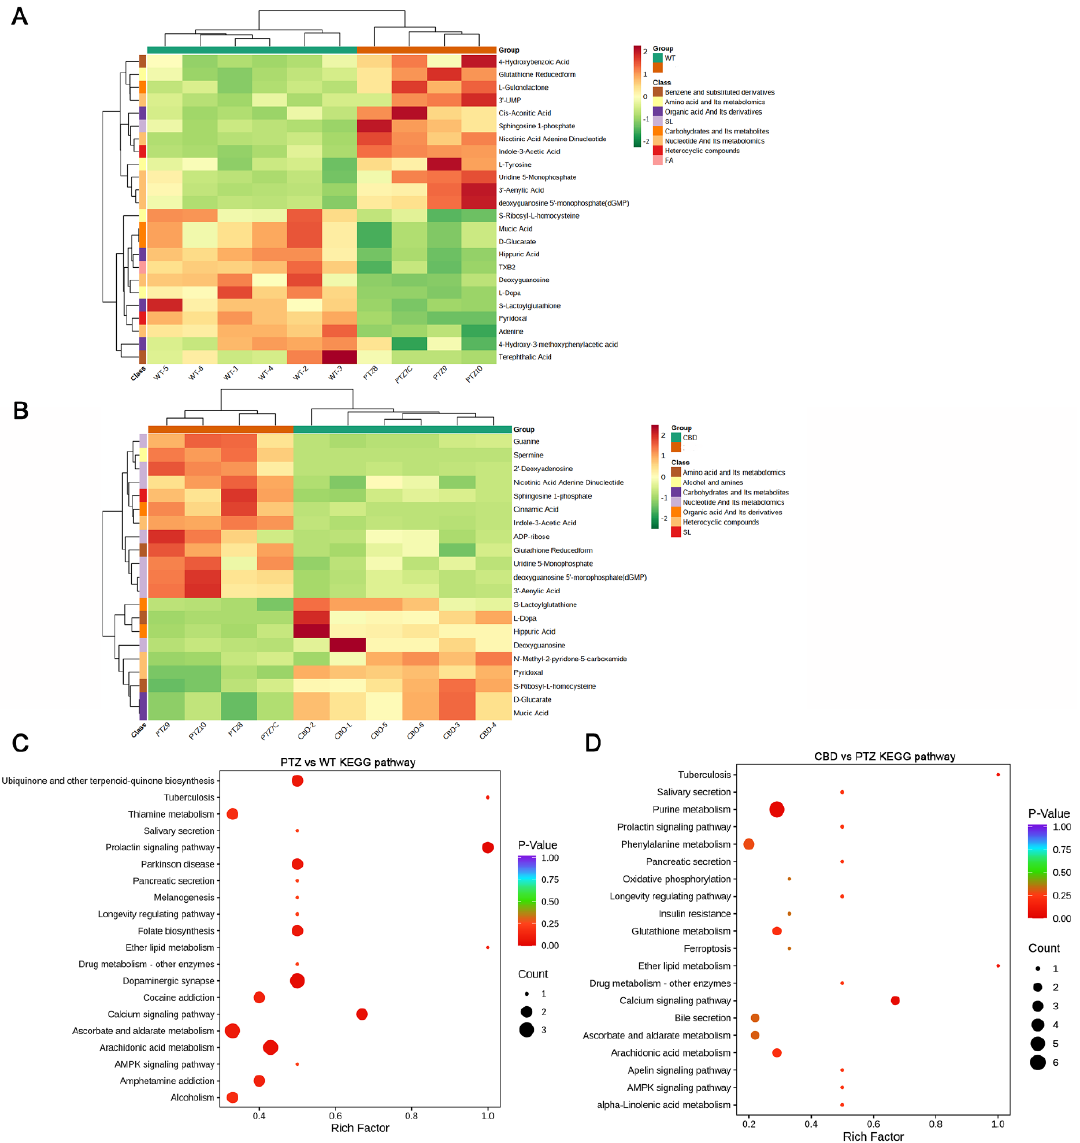
Figure 6. Functional analysis of pathways related to different metabolites in the PTZ and CBD group. The cluster analysis of the PTZ ( A ) and CBD ( B ) group. ( C ) The KEGG enrichment analysis showed the pathways of differential metabolite enrichment after PTZ kindled seizure. ( D ) The pathways of differential metabolite enrichment in hippocampus of PTZ kindled seizure mice treated with CBD.